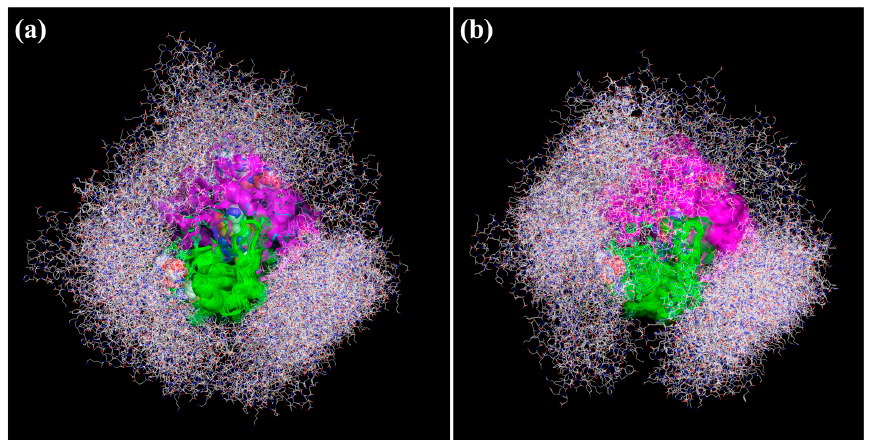
Figure 4. Superimposition of all theoretical complexes between FTH1 and ( a ) PRDX6_r and ( b ) PRDX6_s. Ferritin protein is depicted as wireframe CPK colored, and PRDX6 chains are shown as green and magenta cartoon. Table 1. FTH1 (left) and PRDX6 (right) most relevant, quartile 1, interacting residues. FTH1 Residues Interacting